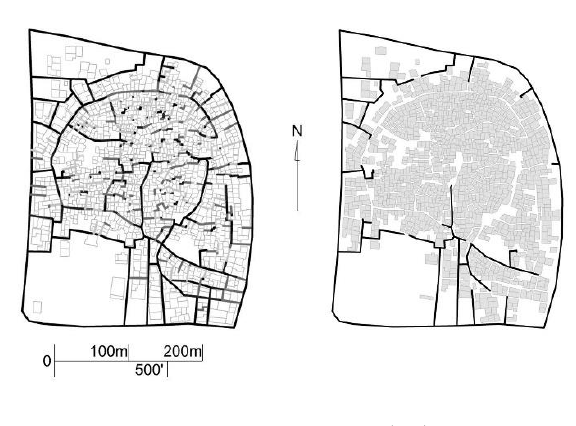
Figure 6. Road width map (left). Figure 7. Remaining road network (right).